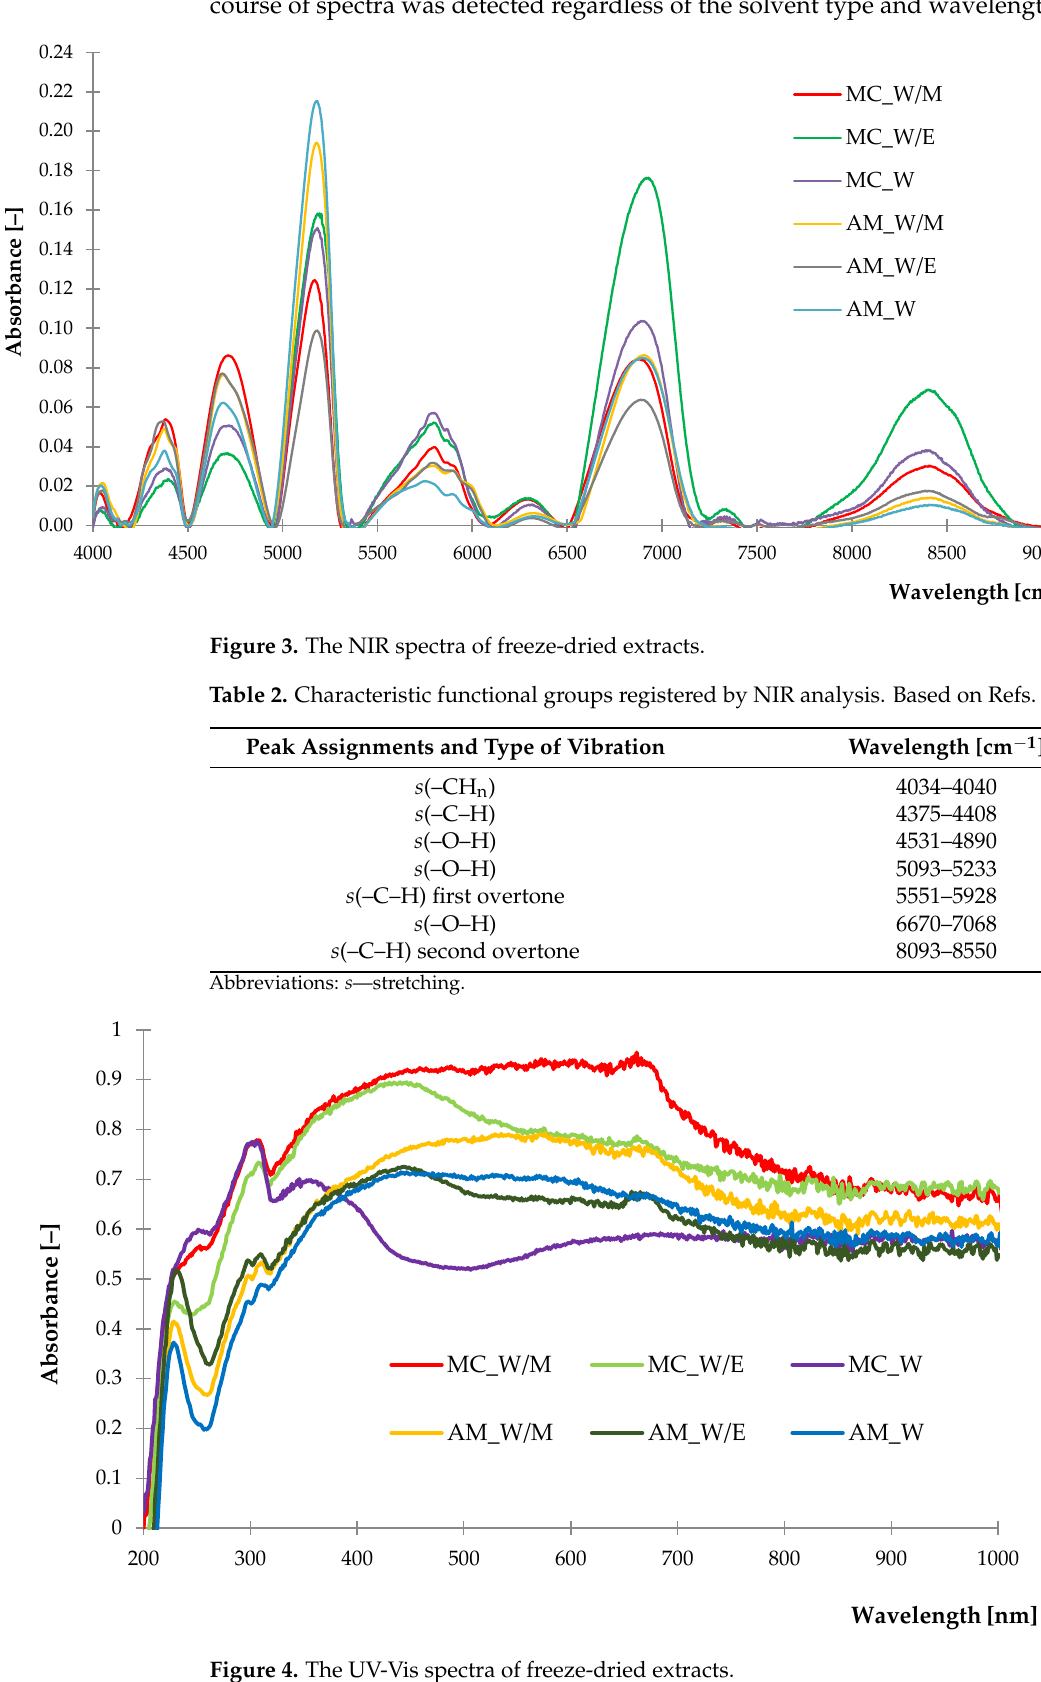
Table 2. Characteristic functional groups registered by NIR analysis. Based on Refs. [59 – 62].